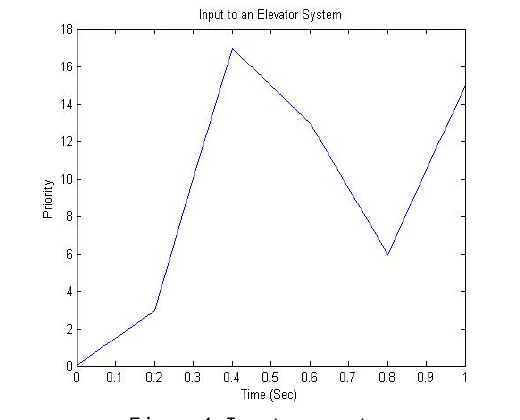
Figure 4. Input parameters